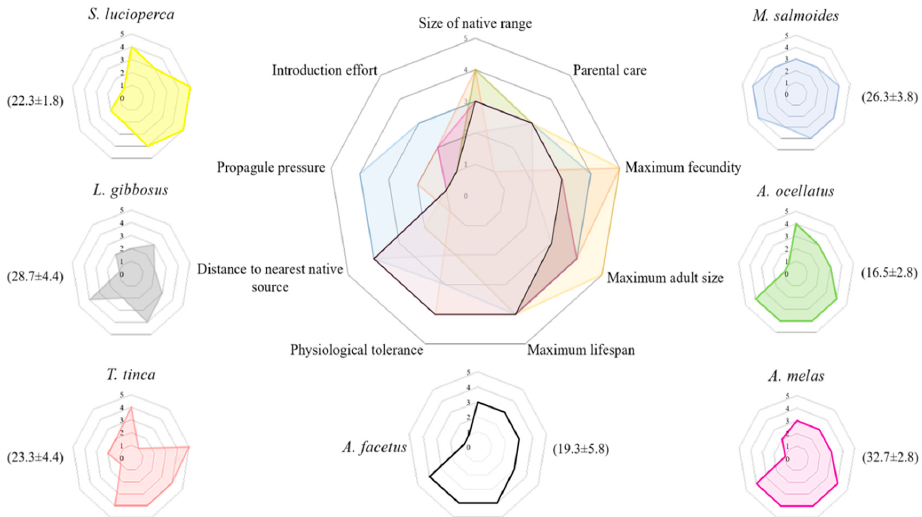
Figure 5. Scoring of biological features and life-history traits represented in radar plots built from the data assessed and provided in [57–59]. This illustration allows the comparison of each potentially advantageous trait among species. Left column: Sander lucioperca , Lepomis gibbosus , Tinca tinca ; Right column: Micropterus salmoides , Astronotus ocellatus , Ameiurus melas . The central diagram superimposes each species with the representation for A. facetus . In parentheses are the FISK v2 scores from Almeida et al.